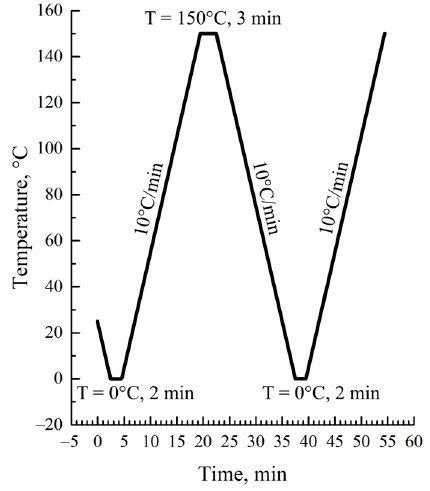
Figure 1. DSC measurement